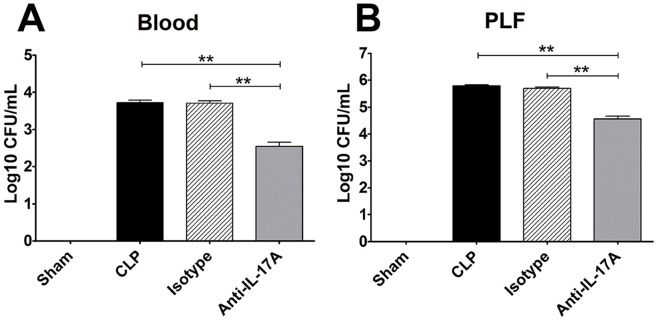
Bacterial clearance after intraperitoneal anti-IL-17A antibody administration.The mice underwent a sham procedure, CLP, CLP with intraperitoneal anti-IL-17A, or isotype administration (n = 10 for each group). Blood and peritoneal lavage fluid were harvested 24 h after surgery. Mice that received intraperitoneal anti-IL-17A antibodies exhibited a deceased bacterial burden in the blood (A) and peritoneal cavity (B) compared with mice that received isotype antibodies or PBS. **P<0.01.